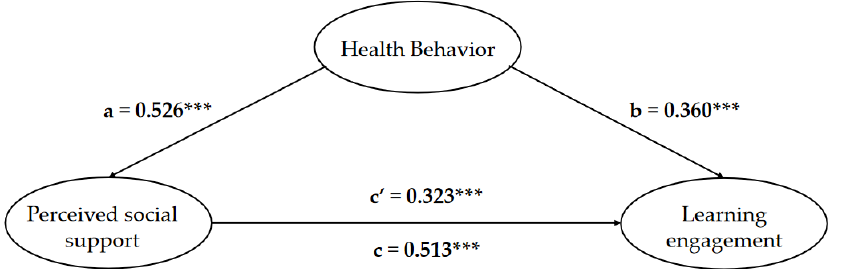
Figure 4. Analysis of the relationship between health behavior, comprehending social support and